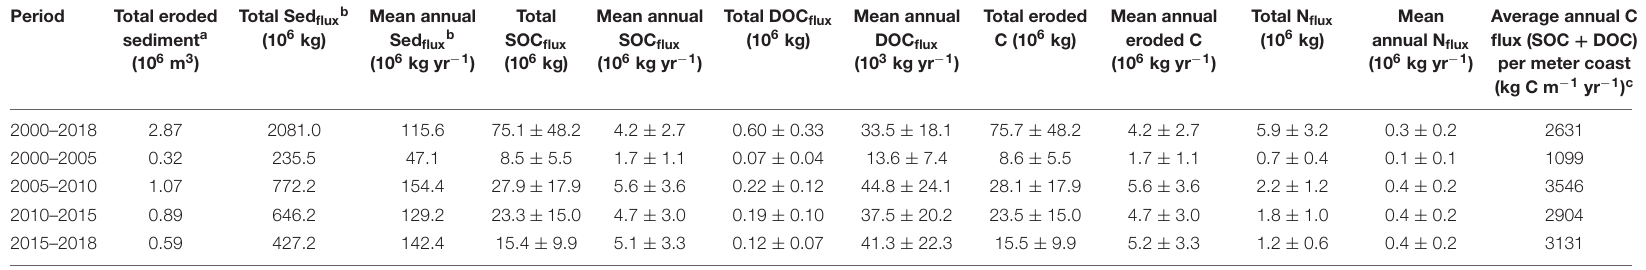
TABLE 2 | Erosion rates of Sobo-Sise Cliff from 1965 to 2018. Period